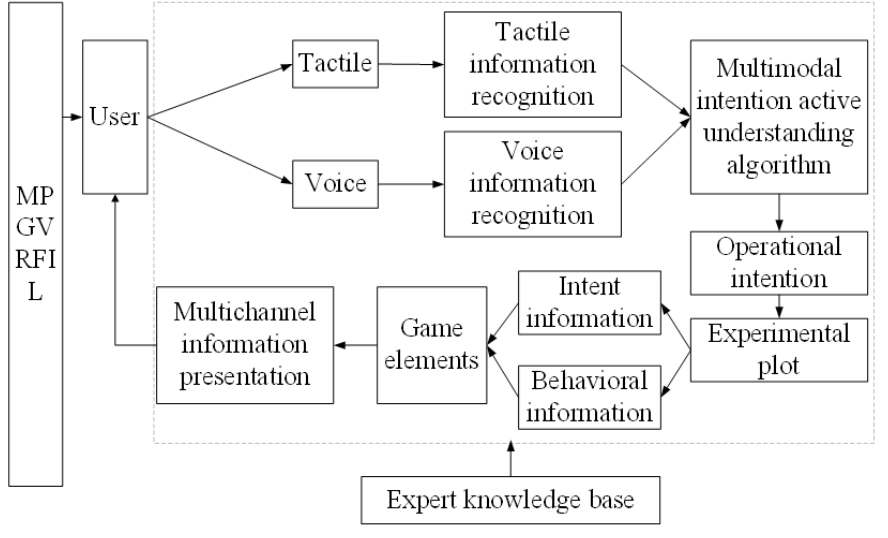
Figure 1. Overall framework.